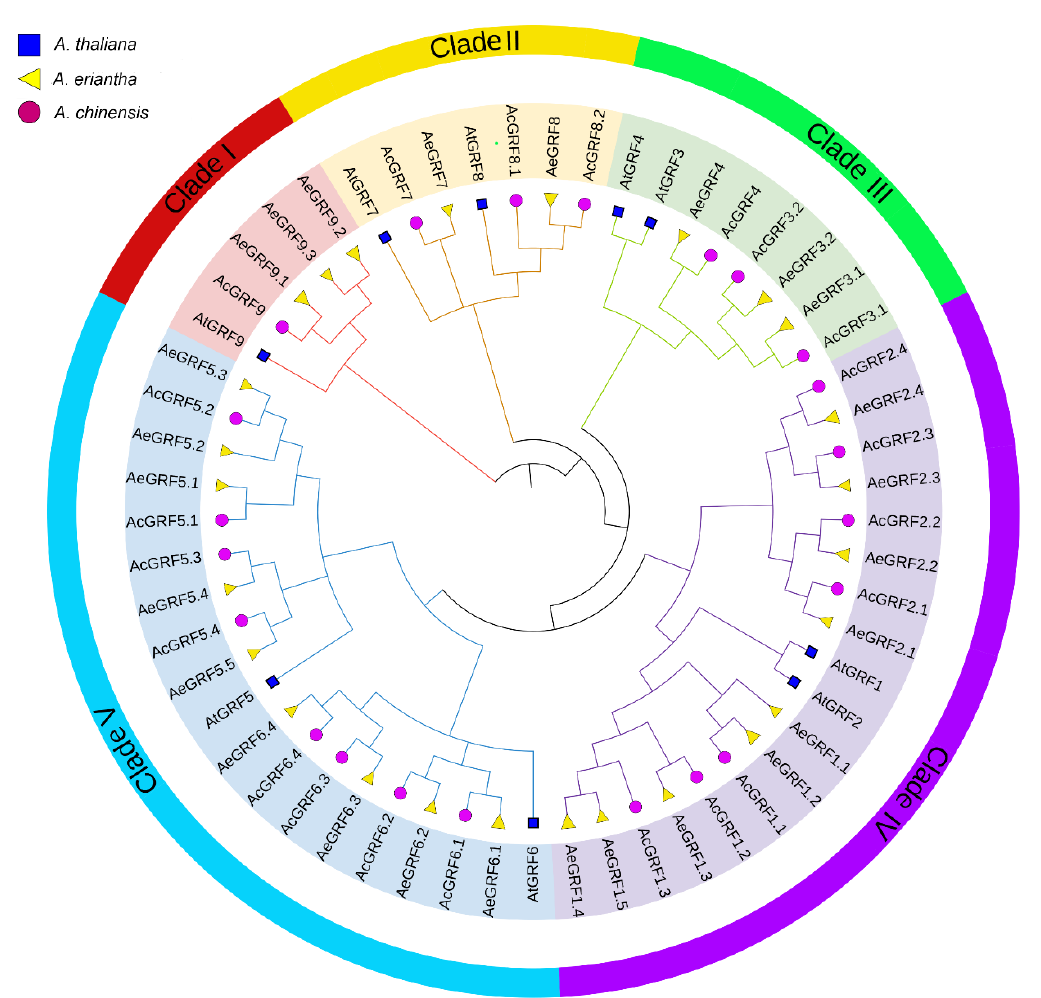
Figure 1. Phylogenetic analysis of AcGRF and AeGRF and AtGRF proteins. Each clade is represented by a different color. The circle shape denotes AcGRF proteins, the triangle shape represents AeGRF proteins and the square shape represents AtGRF proteins.